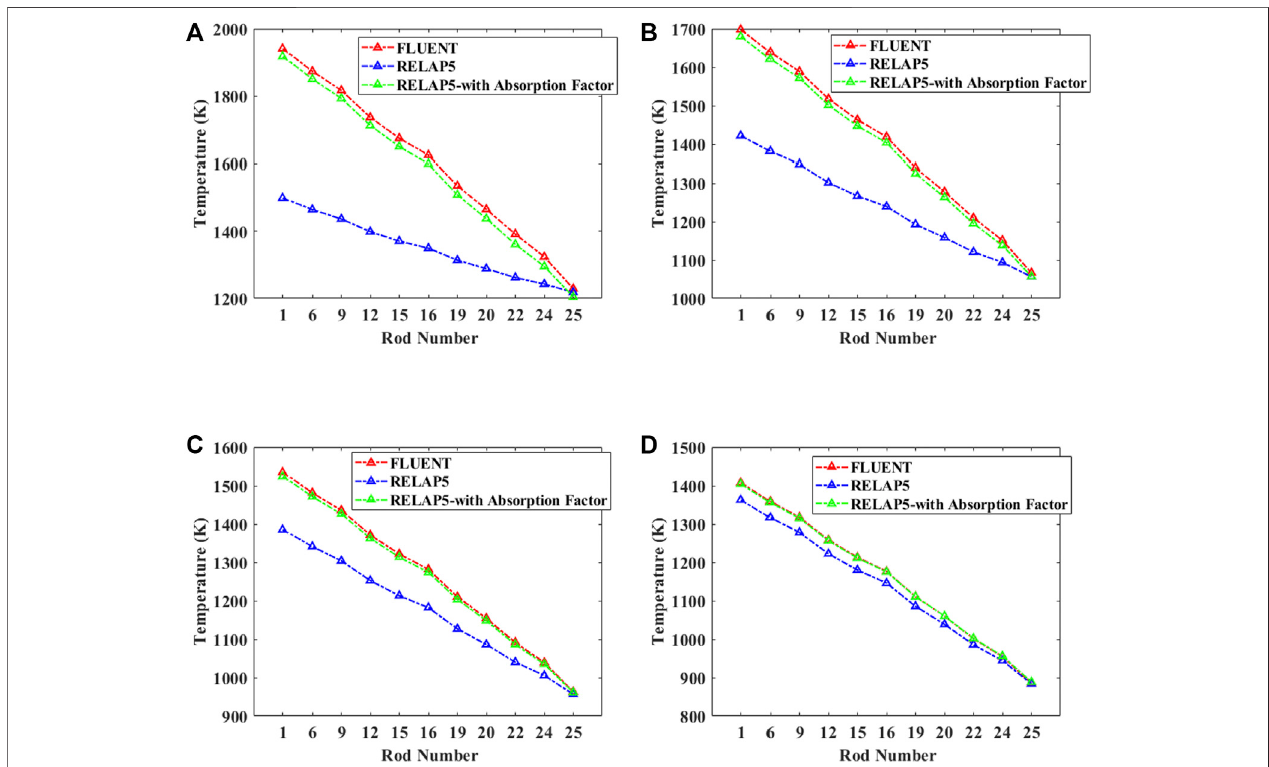
FIGURE 8 | Temperature results for p/d = 1.1: (A) emissivity = 0.3, (B) emissivity = 0.5, (C) emissivity = 0.7, and (D) emissivity = 0.9.